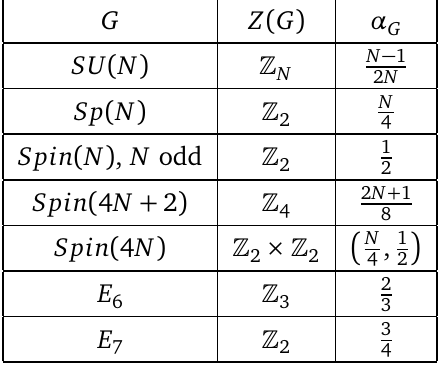
because in this case there are two contri- G ( L ) ∪ C ( R ) ) and C ( L ) + C ( R ) , respectively. Moreover, F 2 2 2 2